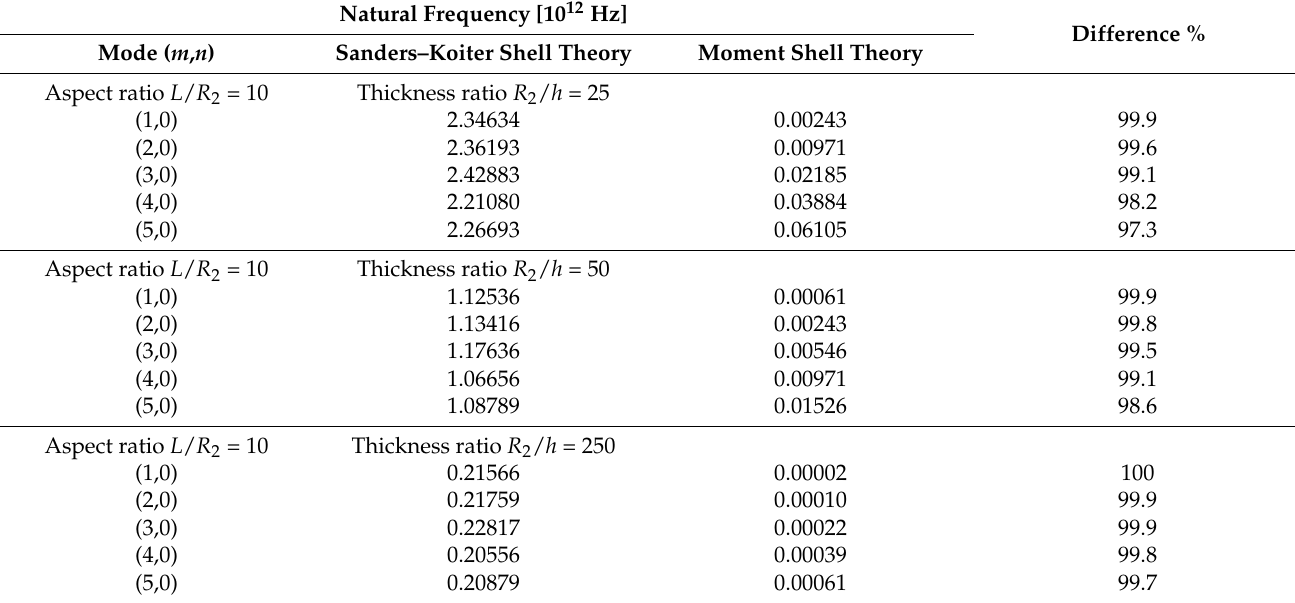
Table 6. Simply supported DWCNT with aspect ratio L / R 2 = 10 and thickness ratios R 2 / h = (25,50,250). Axisymmetric modes ( n = 0). Comparisons between Sanders–Koiter and moment shell theories.